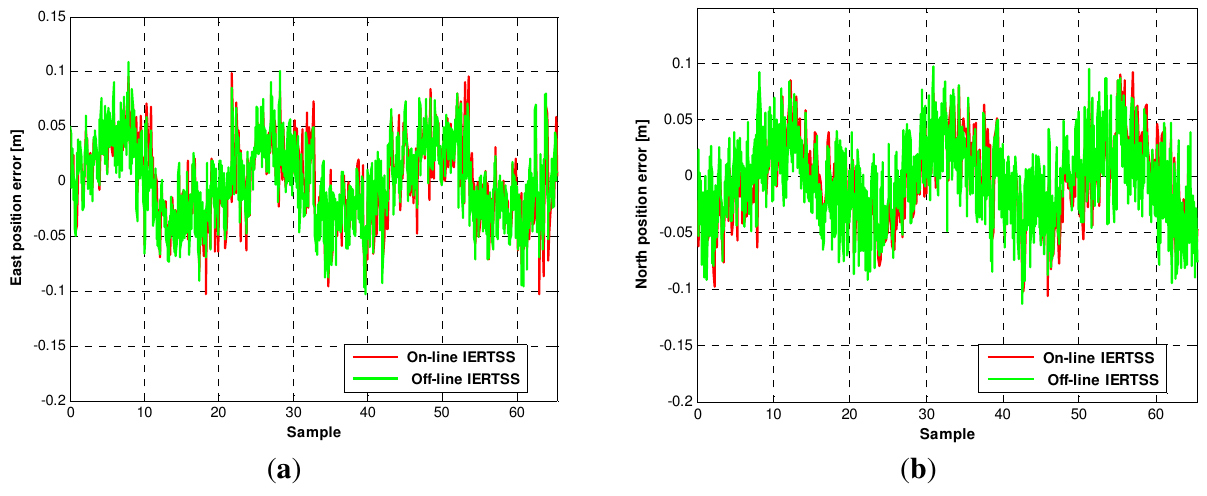
Figure 10. The position error for the off-line IERTSS and on-line IERTSS. ( a ) East direction and ( b ) North direction.